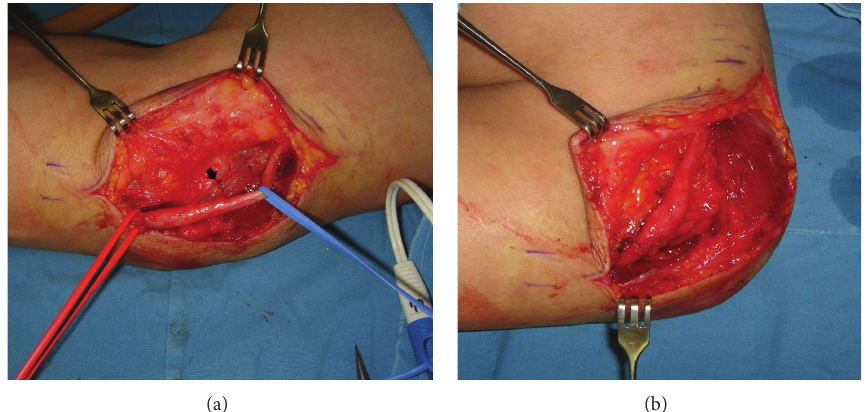
Figure 1: Nerve release and anterior transposition. (a) Feeding artery vessel (arrow) of nerve must be saved. (b) Anterior transposition of the ulnar nerve was conducted followed by dissection to achieve sufficient release without compression of the ulnar